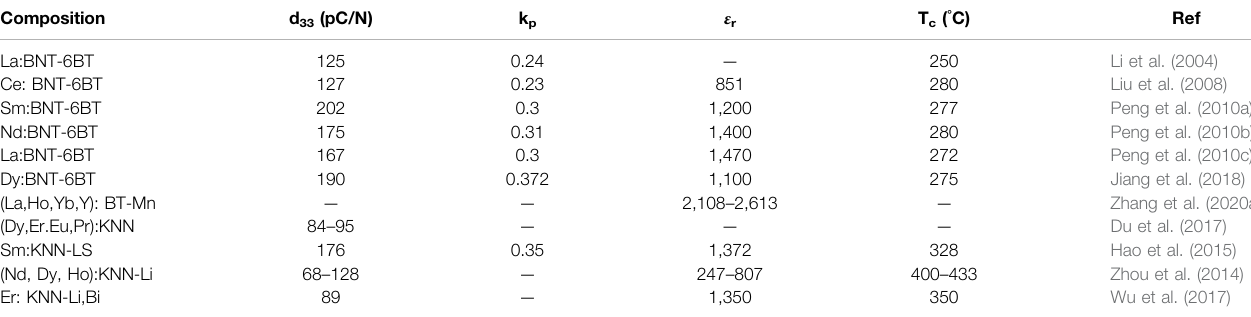
TABLE 2 | The properties of some lead-free based piezoelectric ceramics with rare-earth doping.